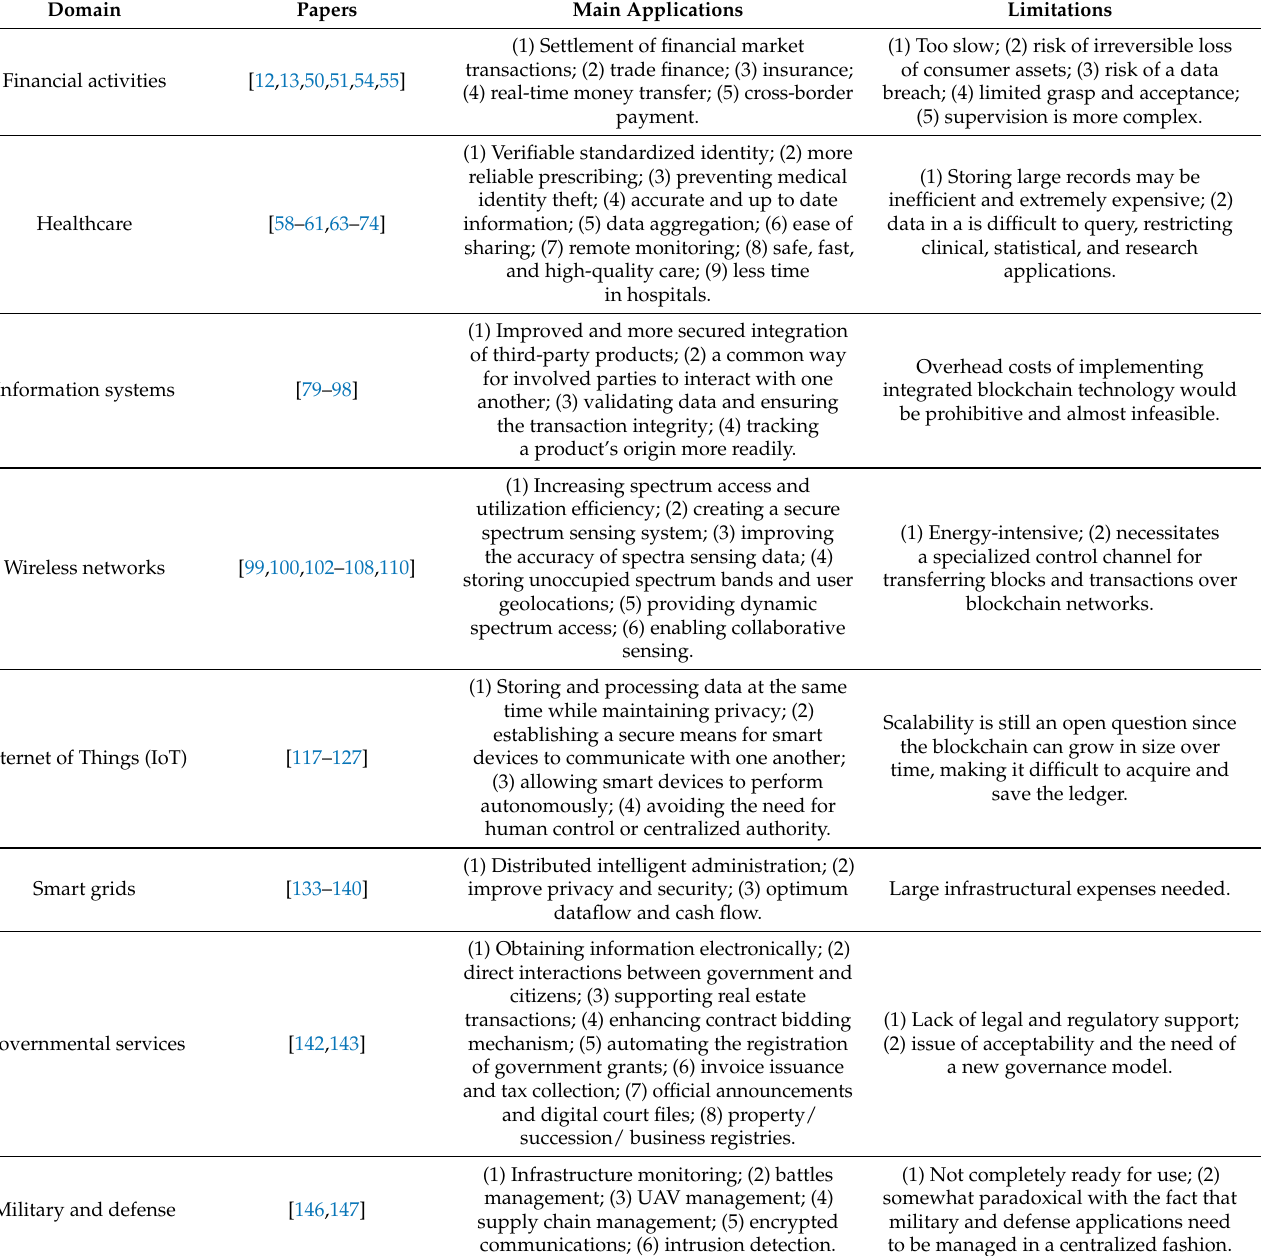
Table 4. Summary of the main findings concerning the use of blockchain in different